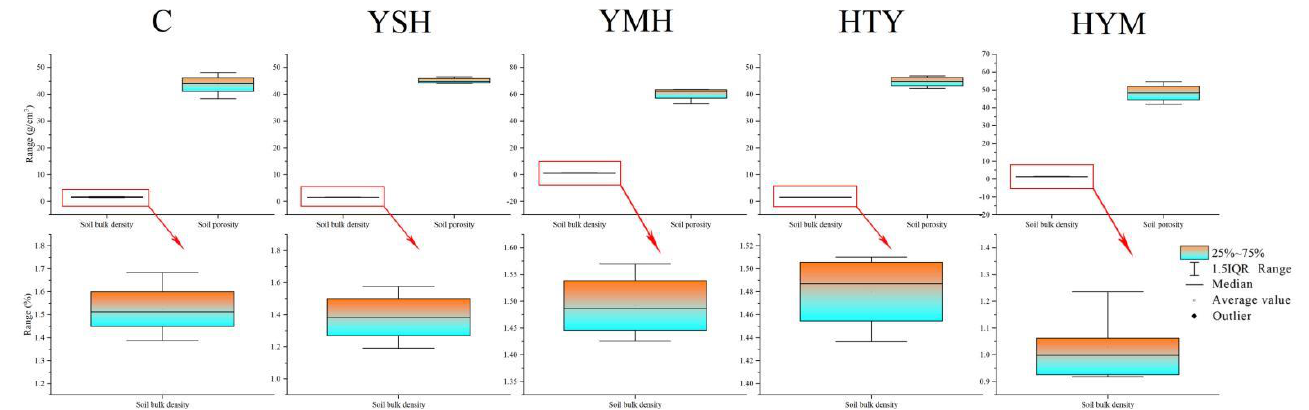
Figure 3. Soil porosity and bulk density of different agroforestry.